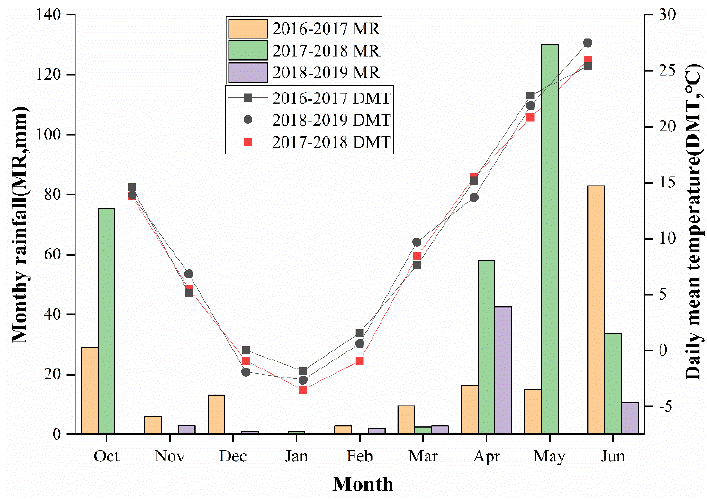
Table 1. The soil bulk density and field capacity in 0–200 cm soil layers in the experimental plots.